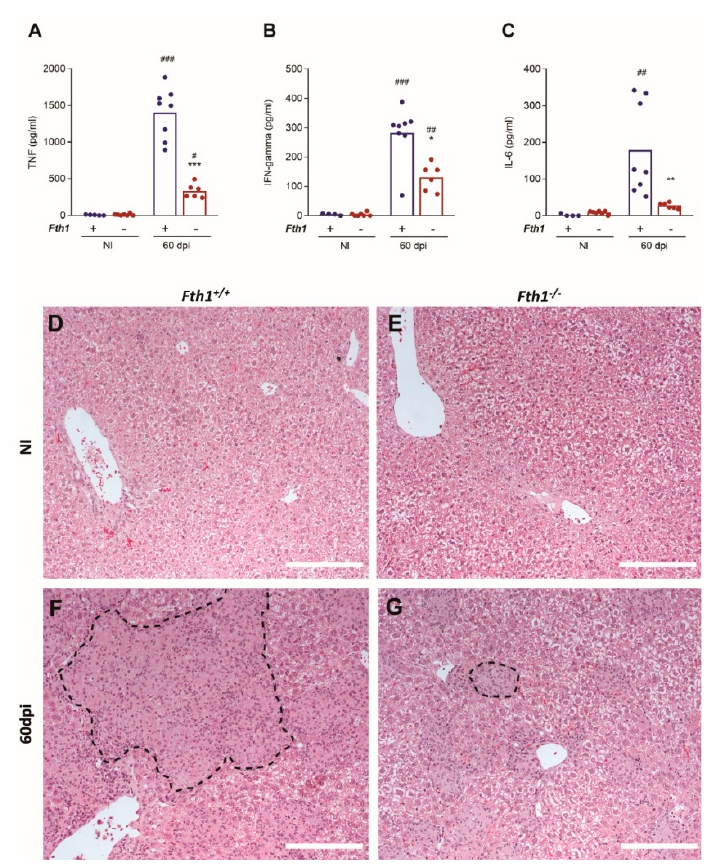
Figure 2. Inflammatory response in mice infected with M. avium . Fth1 +/+ (blue) and Fth1 − / − (red) mice were intravenously infected with 10 6 CFU of M. avium 25291 and euthanized 60 days later. ( A ) TNF-alpha, ( B ) IFN-gamma, and ( C ) IL-6 were measured in the serum, using a cytometric bead array kit. Bars represent the mean, and the circles represent individual values of 4 to 8 animals per group. Statistics: two-way ANOVA followed by Sidak multiple-comparison post hoc test. * p < 0.05, ** p < 0.01, *** p < 0.001 when comparing Fth1 +/+ to Fth1 − / − mice. ## p < 0.01, ### p < 0.001 when comparing infected to noninfected mice of the same genotype. ( D – G ) Representative images of H&E-stained liver sections from noninfected (NI) and infected (60 dpi) Fth1 +/+ and Fth1 − / − mice. Representative granulomas are outlined. Scale bar: 200 µ